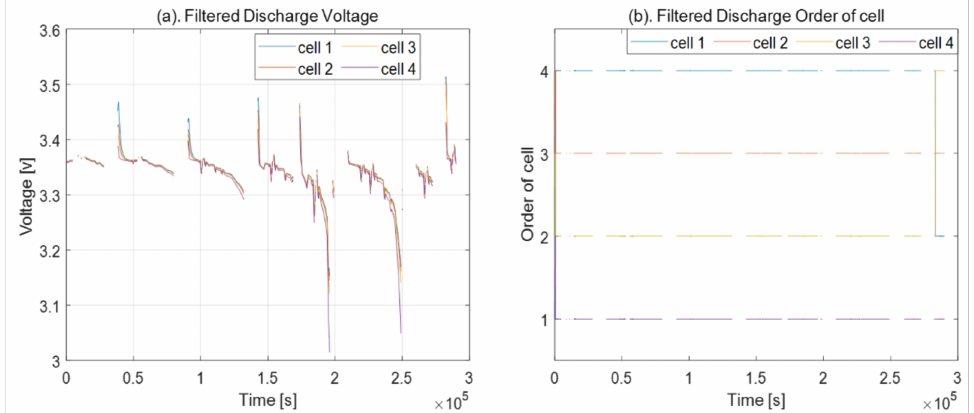
Figure 11. Simulink data with cell balancing problem (( a ) filtering the discharge part in cell balancing problem voltage data, and ( b ) an order of cell